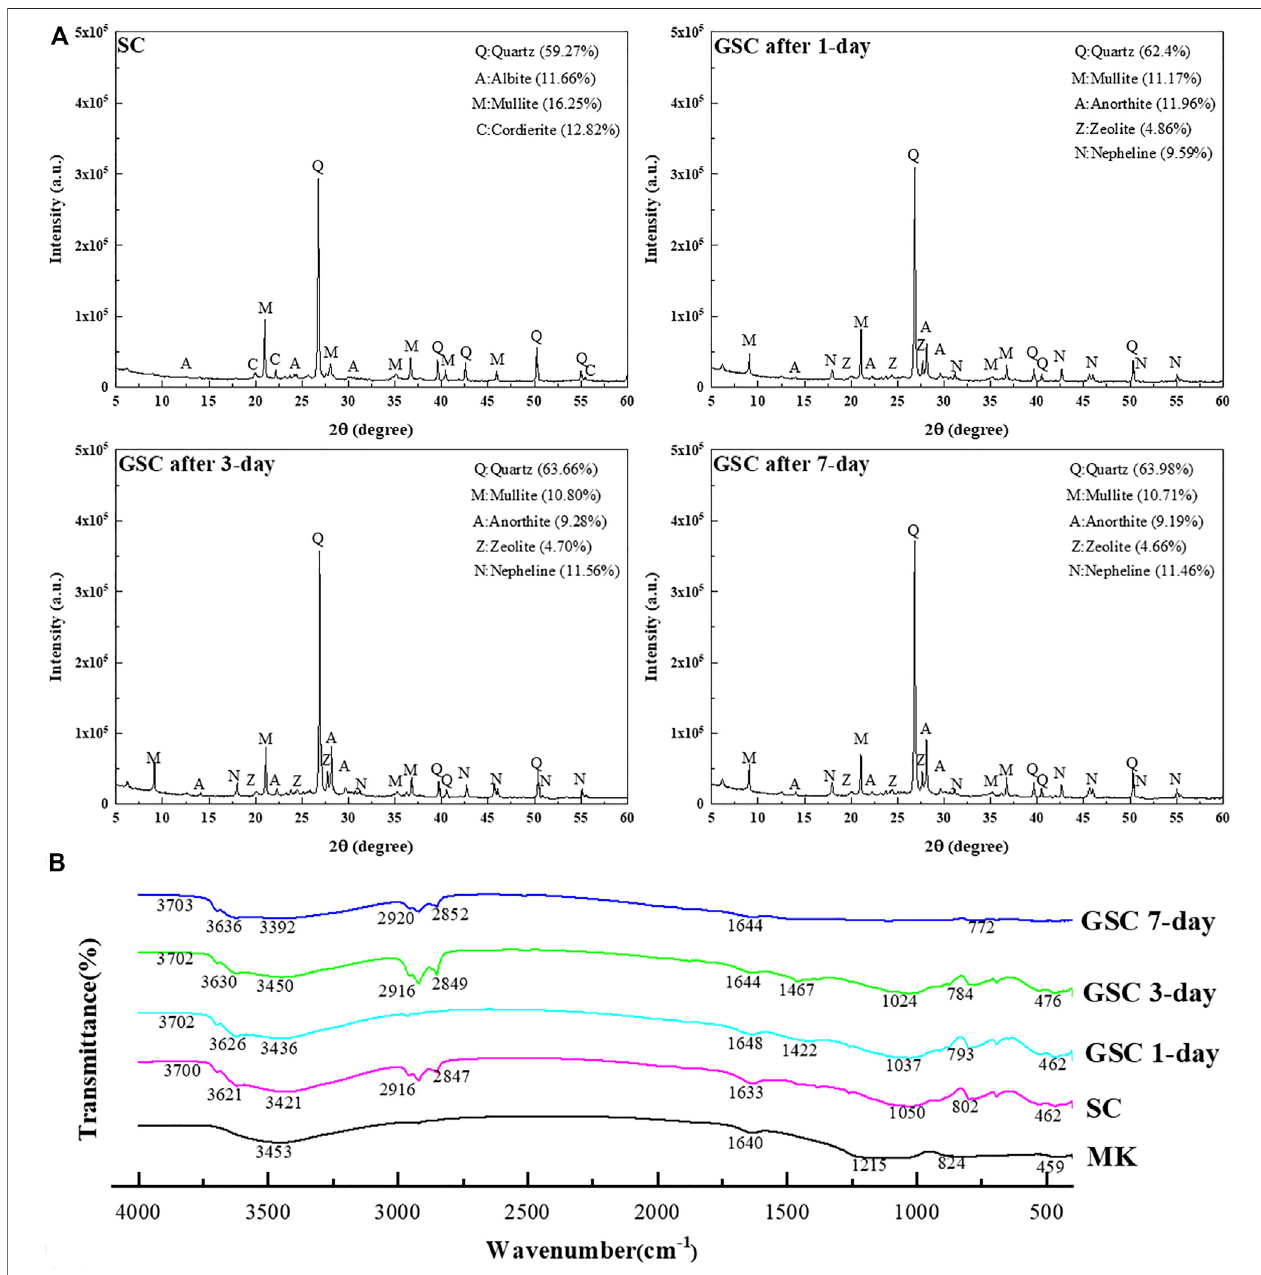
FIGURE 2 | XRD pattern and FTIR spectra of SC and GSC specimens after 1 day, 3 days, and 7 days.